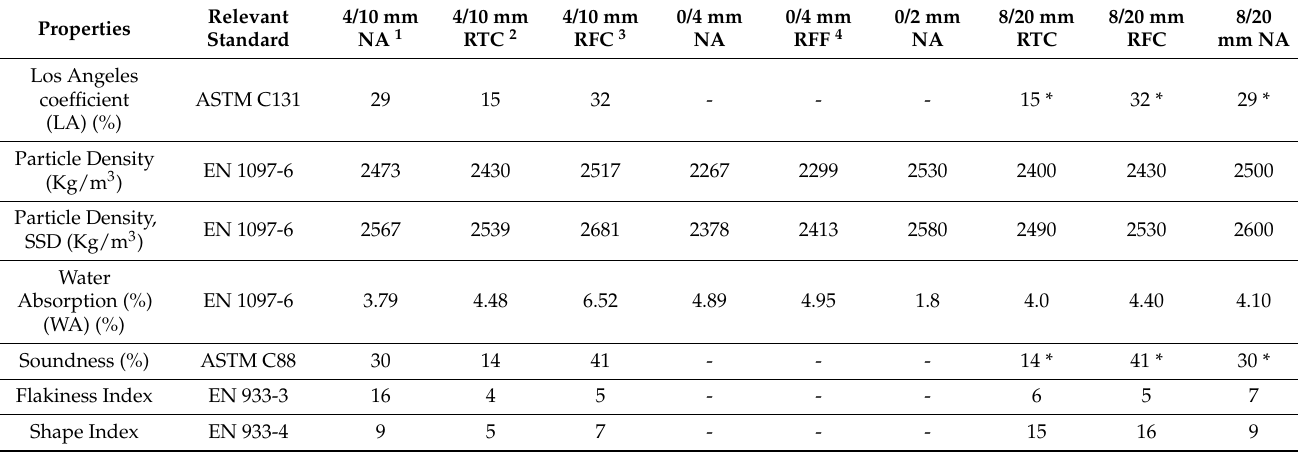
Table 1. Properties of aggregates.